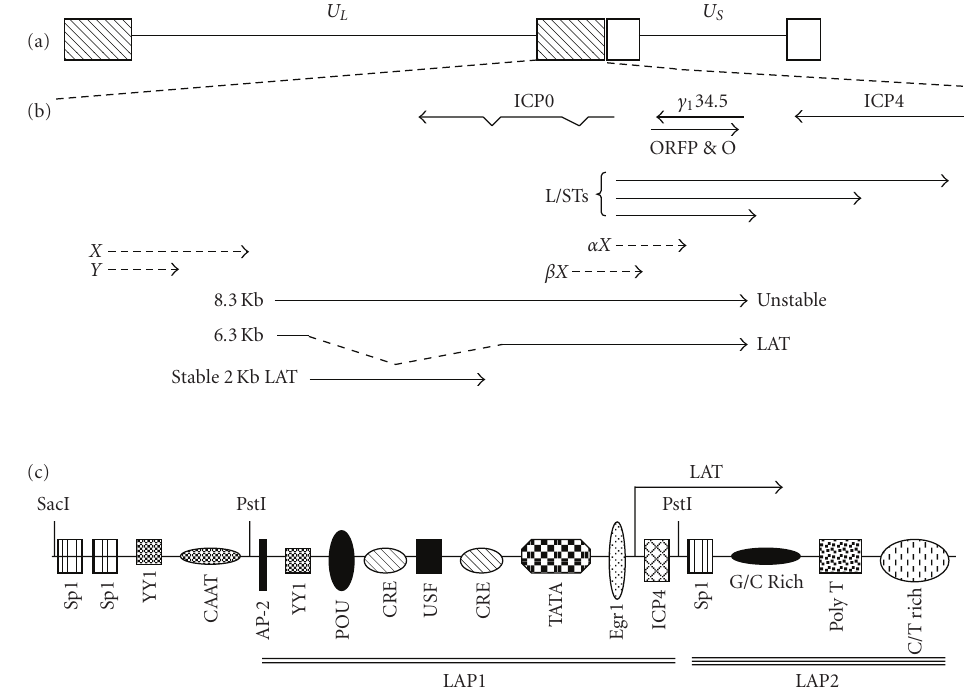
Figure 2: Location of genes within the HSV-1 repeats. (a) U L and U S denote the unique sequences of the long ( L ) and short ( S ) components of the genome. The boxes depict repeat sequences. (b) Transcription map of the repeat region. Location and orientation of LAT [114, 115], ICP0, γ 134.5 [116, 117], ORFP [118], L/STs [119] are indicated by solid lines. Partially mapped transcripts ( α X and β X) are denoted by dashed arrows [120, 121]. (c) The LAT promoter contains numerous cis-acting sites that can be bound by cellular transcription factors. Binding of ICP4 to the ICP4 binding site in the LAT promoter inhibits promoter activity [107]. In transient transfection assays, the LAT promoter can be divided into a strong promoter (LAP1) and a weaker promoter (LAP2) [99, 100]. For details of transcripts encoded by LAT, see Figure